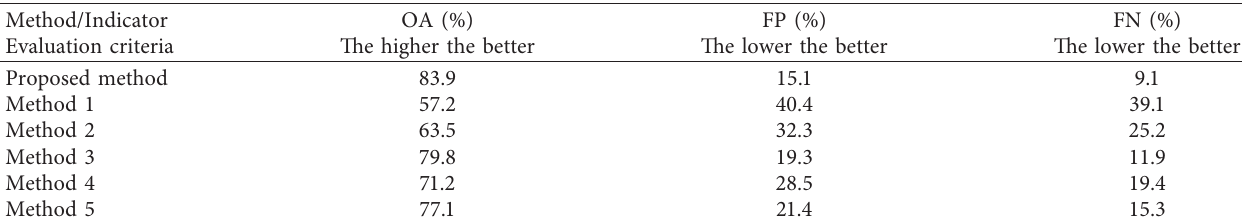
Table 4: Quantitative evaluation of CD accuracy in dataset 1.